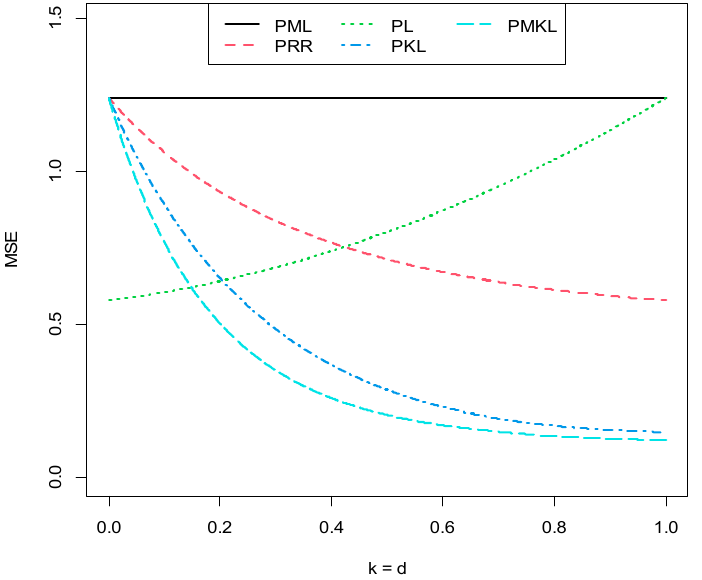
Figure 2. MSE values of the non-robust estimators against k and d of the aircraft damage data.